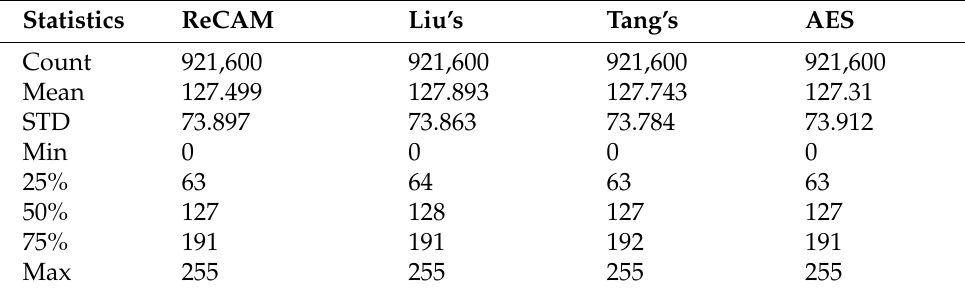
Table 5. Comparative security and performance